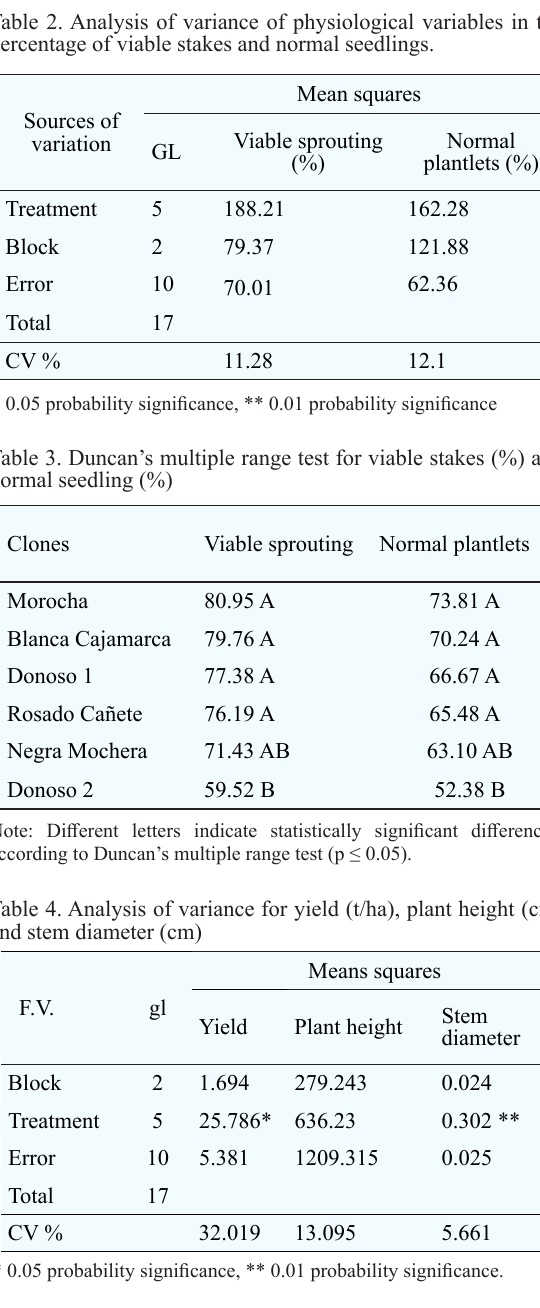
Table 5. Duncan’s multiple range test for yield, plant height and stem diameter